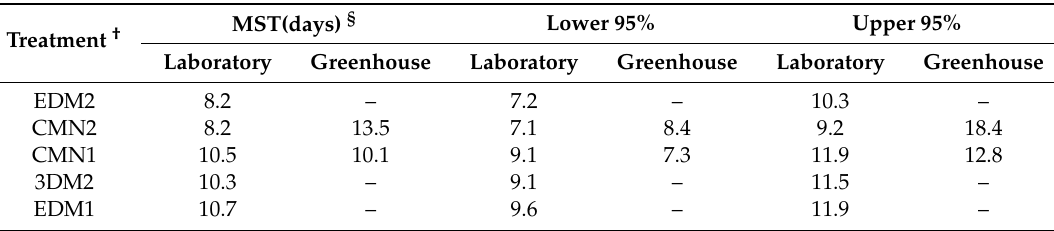
Table 3. Median survival time (MST) in days of third-instar nymphs of the migratory grasshoppers, Melanoplus sanguinipes , treated with di ff erent concentrations of Paranosema locustae and Metarhizium brunneum F52 for 16 days in laboratory and greenhouse conditions.